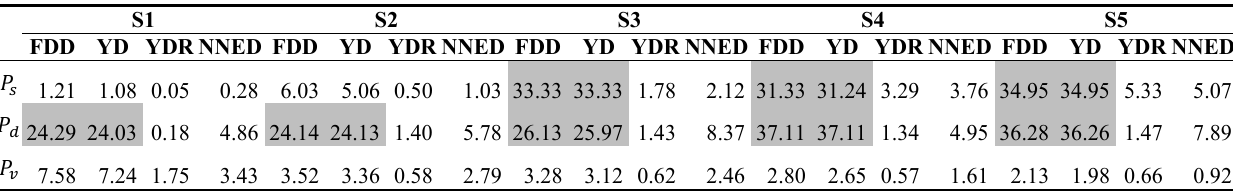
Figure 6. Estimation errors (in dB) of model-fitting-based decomposition methods with respect to the azimuth slope angle. The first, second and third row are errors for three different size categories: ( a ) S1, ( b ) S3, and ( c ) S5. Table 3. RMSE of each decomposition method for the azimuth slope variation. Shaded cells represent that an azimuth profile of the calculated scattering component contains negative